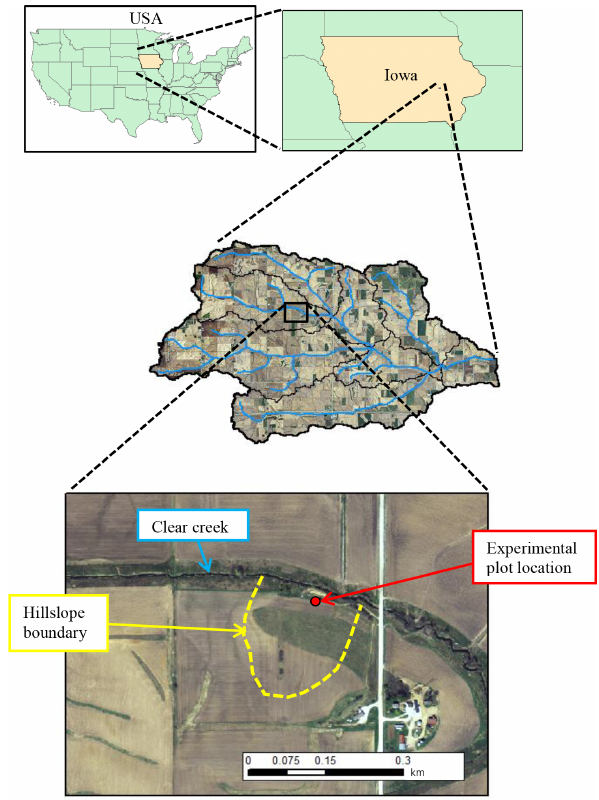
Figure 1. Location of experimental plot in the headwaters of Clear Creek, IA (41.74 ◦ N, − 91.94 ◦